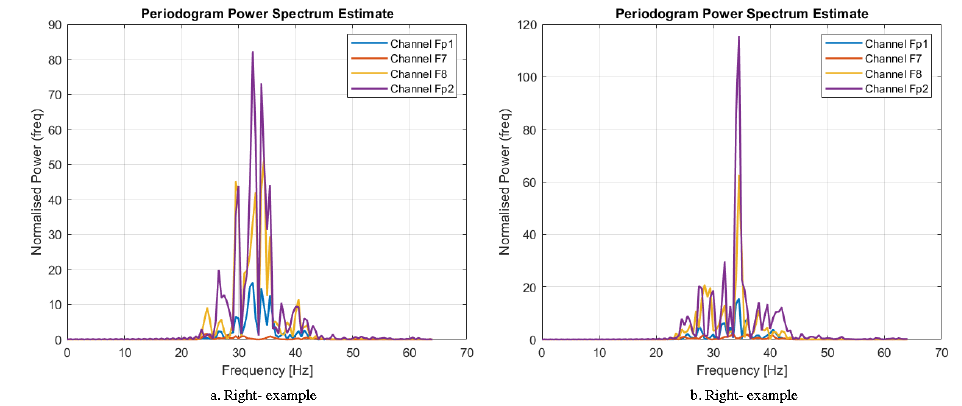
Figure 8. An example of the power spectrum estimation result for participants 5 and